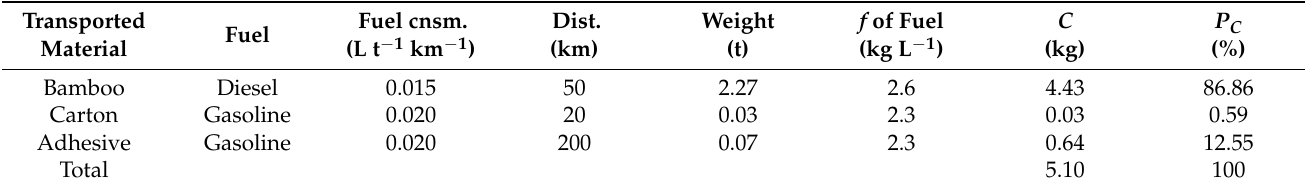
Table 2. CO 2 emissions for transportation in producing 1 t of FBCBs.